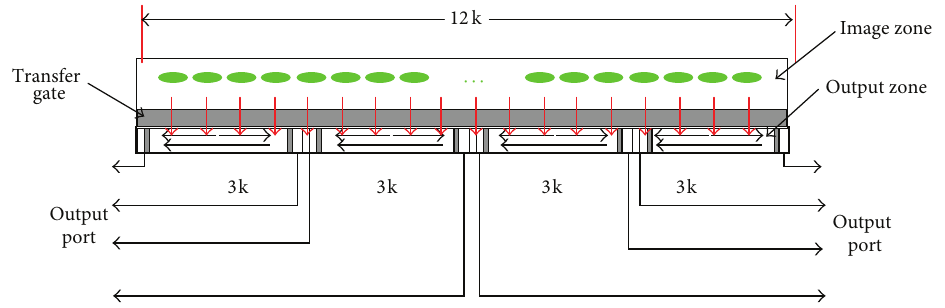
Figure 15: The outline structure of the linear